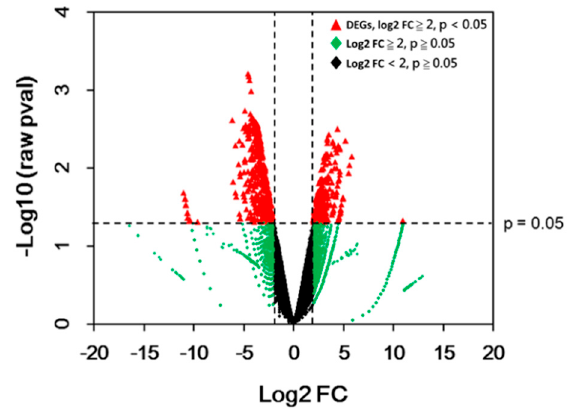
Figure 4. Volcano plot of genes in white versus green sectors. Data for all genes are plotted as log2 fold change (FC) versus the –log10 of raw p -value (pval). Genes that were considered differential expressed genes (DEGs) are highlighted as a red dot. The horizontal dashed line indicates the significant threshold of the p -value, whereas the vertical dashed lines represent the threshold of log2 fold change = 2 or − 2.